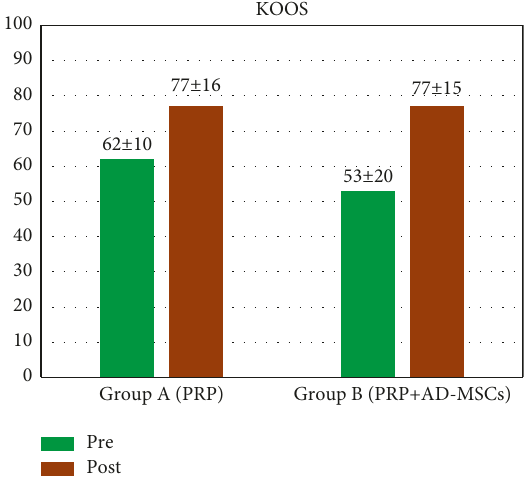
Figure 3: KOOS (Knee Injury Osteoarthritis Outcome Score): pretreatment and at 12-months follow-up.